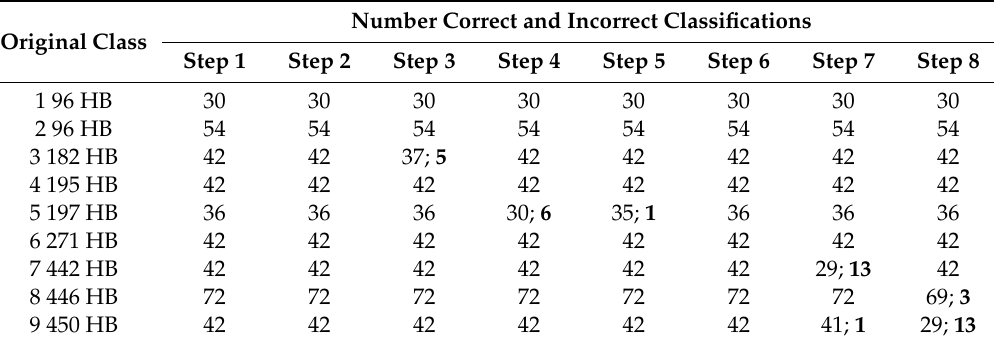
Table 4. Averaged results of classifications of ANNs in each step.